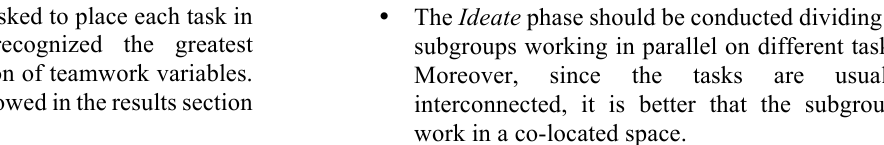
Fig. 1: The perceived most effective combination of spatial distribution and organization of team for each task of the